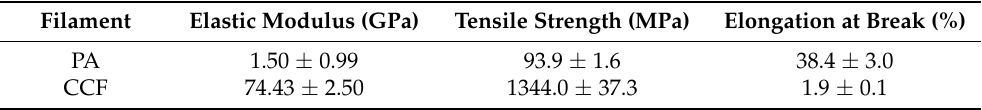
Figure 5. Tensile stress–strain behavior and fractured surface morphology of ( a ) PA and ( b ) CCF filaments. Table 6. Mechanical properties of PA and CCF filaments. The value of the elastic modulus of the CCF tow was obtained from [34] as the extensometer could not be used during tensile test due to its low diameter (i.e., 380 µ